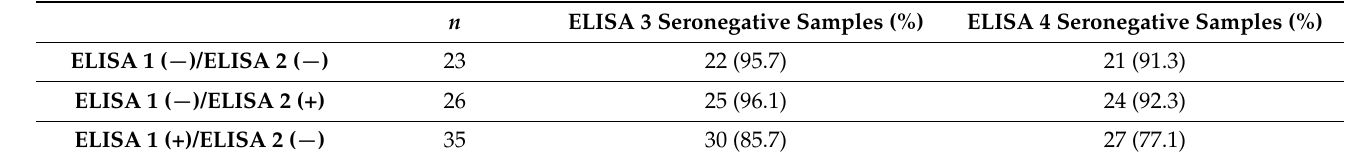
Table 3. Additional analysis of 84 ELISA 1 (IDEXX PRRS X3) and/or or ELISA 2 (CIVTEST